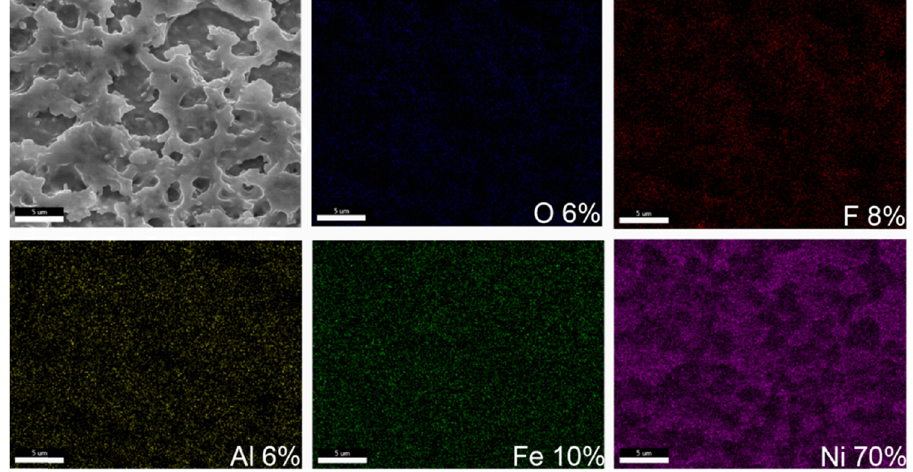
Figure 11: EDS diagram of the surface of the wrench treated with T liquid for 30 min after anodic